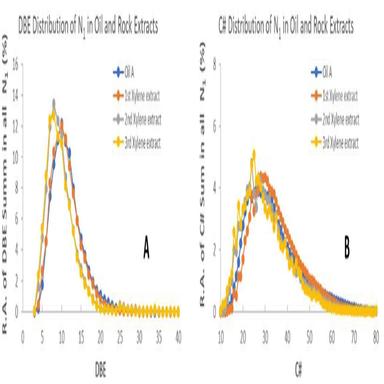
DBE distribution (A) and C# distribution (B) of the basic N1 species in Oil A and the first three xylene extracts.